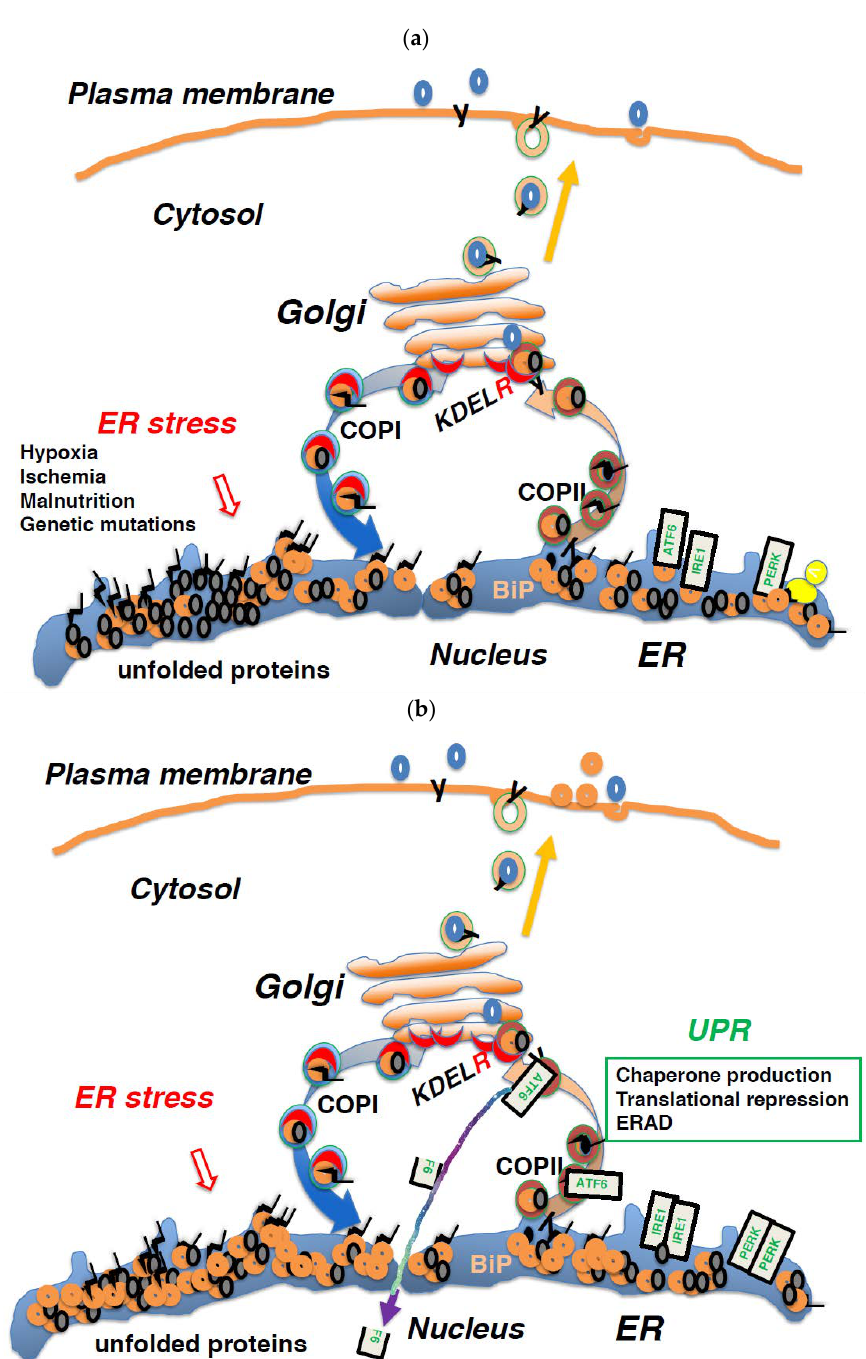
Figure 3. ( a ) Unfolded proteins accumulate in the ER when protein folding is disturbed due to ER stress, which may result from either intrinsic defects (e.g., mutated sequences, missing subunits) or extrinsic injuries (e.g., ischemia, malnutrition, hypoxia, and toxicity). ( b ) BiP dissociates from ATF6, IRE1, and PERK, and associates with unfolded proteins; dissociation from BiP activates ATF6, IRE1, and PERK, and initiates the unfolded protein response (UPR). The cytoplasmic portion of ATF6 is transported to the nucleus; there, it functions as a transcription factor, binding to ER stress response element (ERSE) and promoting the transcription of genes important for the UPR. The UPR increases the ability of cells to deal with increased levels of unfolded proteins through chaperone production, translational repression, and ER-associated protein degradation